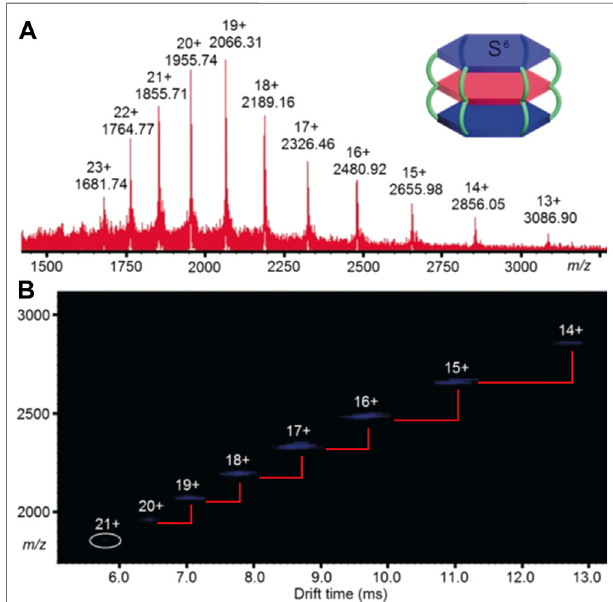
FIGURE 7| Comparison of (A) ESI-HRMS and (B) ESI-TWIMS-MS data showing the distinct charge state step change, highlighted with red lines showingchangeintimeand m/z .Notethestepchangeisnotaconstantvalue because the effect of a single charge difference increases as charge decreases (Liu et al.,